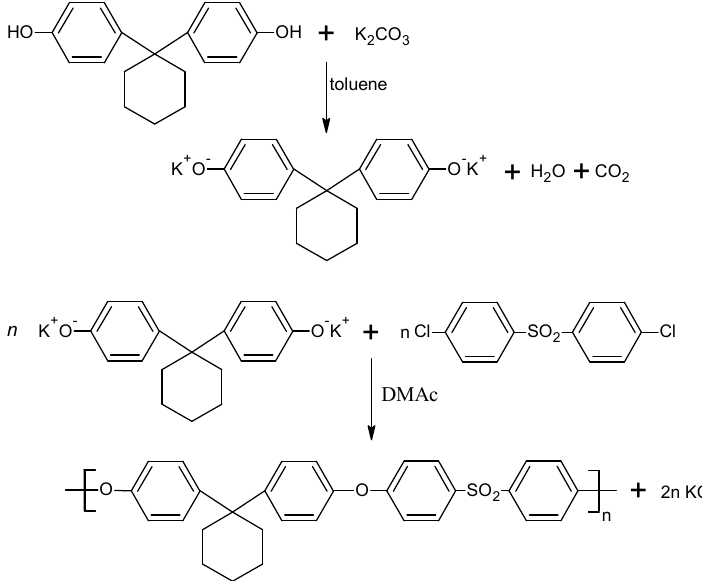
Figure 3. Reaction scheme for the synthesis of bisphenol Z polysulfone (PSU-BPZ).